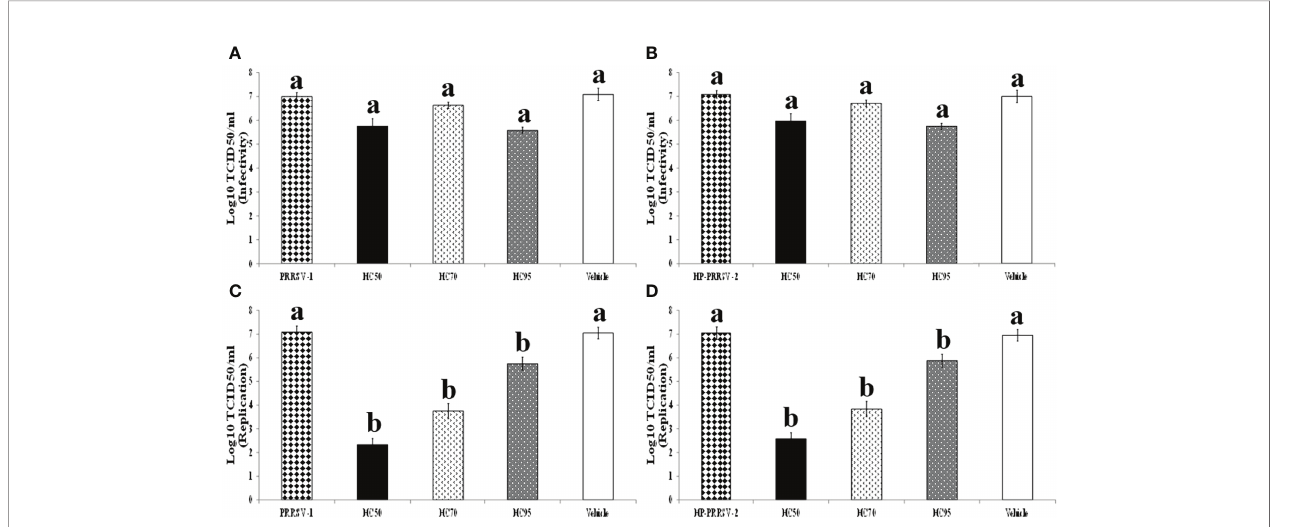
FIGURE 4 | Effects of HC50, HC70, and HC95 on PRRSV-1 and HP-PRRSV-2 infectivity and replication in vitro . (Top panel) HC50 (black bar), HC70 (divot bar), and HC95 (dotted bar) were incubated with 10-fold serially diluted PRRSV-1 (A) and HP-PRRSV-2 (B) for 1 h prior to subsequent inoculation onto adherent MARC- 145 cells. The cultures were incubated for 1 h, then the supernatants were removed, and the cells were washed and incubated further in MEM ++ for 96 h. (Bottom panel) MARC-145 cells were inoculated with 10-fold serially diluted PRRSV-1 (C) and HP-PRRSV-2 (D) for 1 h, then the supernatants were discarded, and the cultures were washed and further incubated with HC50 (black bar), HC70 (divot bar), and HC95 (dotted bar) for 96 h. The virus titers were determined by IPMA. MARC-145 cells receiving only serially diluted PRRSV and vehicle solution served as PRRSV and vehicle controls, respectively. One-way ANOVA, followed by Dunnett ’ s test was used to determine the signi fi cant difference in mean virus titers. Error bar indicates the SEM. Different letters represent a signi fi cant mean difference among groups ( p <